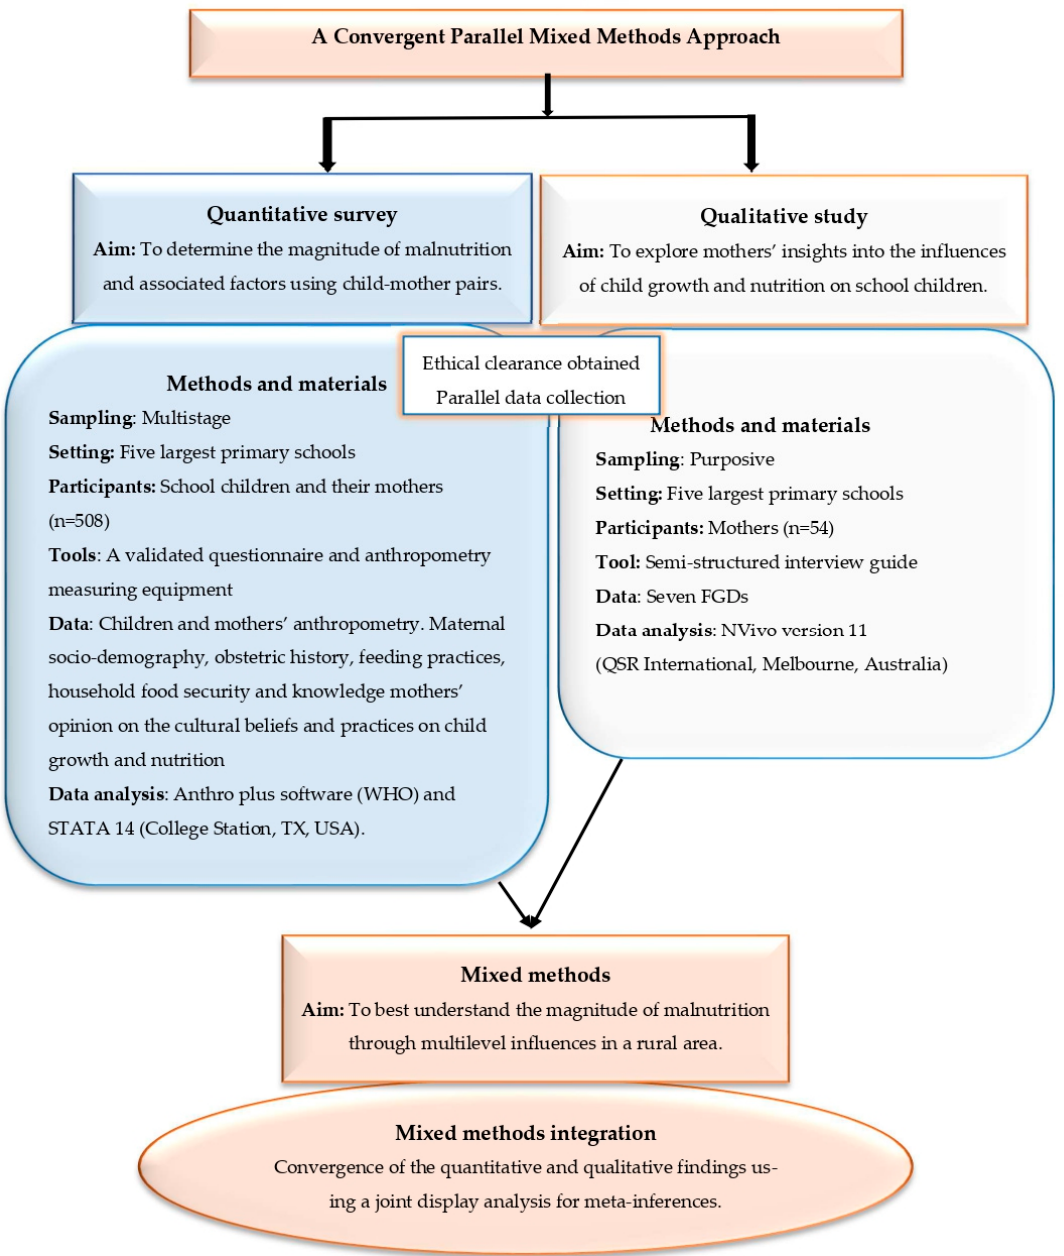
Figure 1. A convergent parallel mixed methods approach to investigate the multidimension of malnutrition among children. Developed by Modjadji and Madiba, 2022.